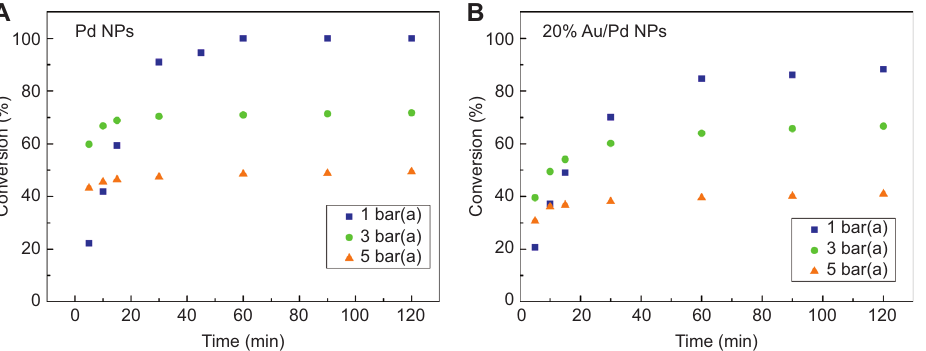
Figure 7 Conversion vs. time plots for the benzyl alcohol oxidation in batch at different oxygen pressures (A) with monometallic Pd NPs and (B) with 20% Au/Pd NPs. Reaction conditions: 1 mmol benzyl alcohol, 25 μ mol Pd NP in 10 ml i PrOH/water (ratio 4/1), 50 ° C.